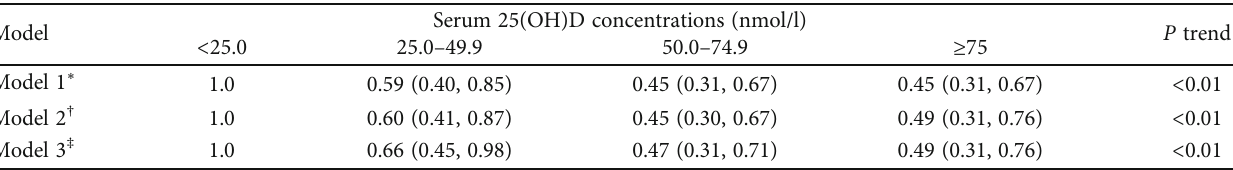
Table 3: Competing risk of death with or without accident (unintentional injuries) and malignant neoplasm cause according to serum 25(OH)D concentrations among patients with DKD in NHANES 2001 –